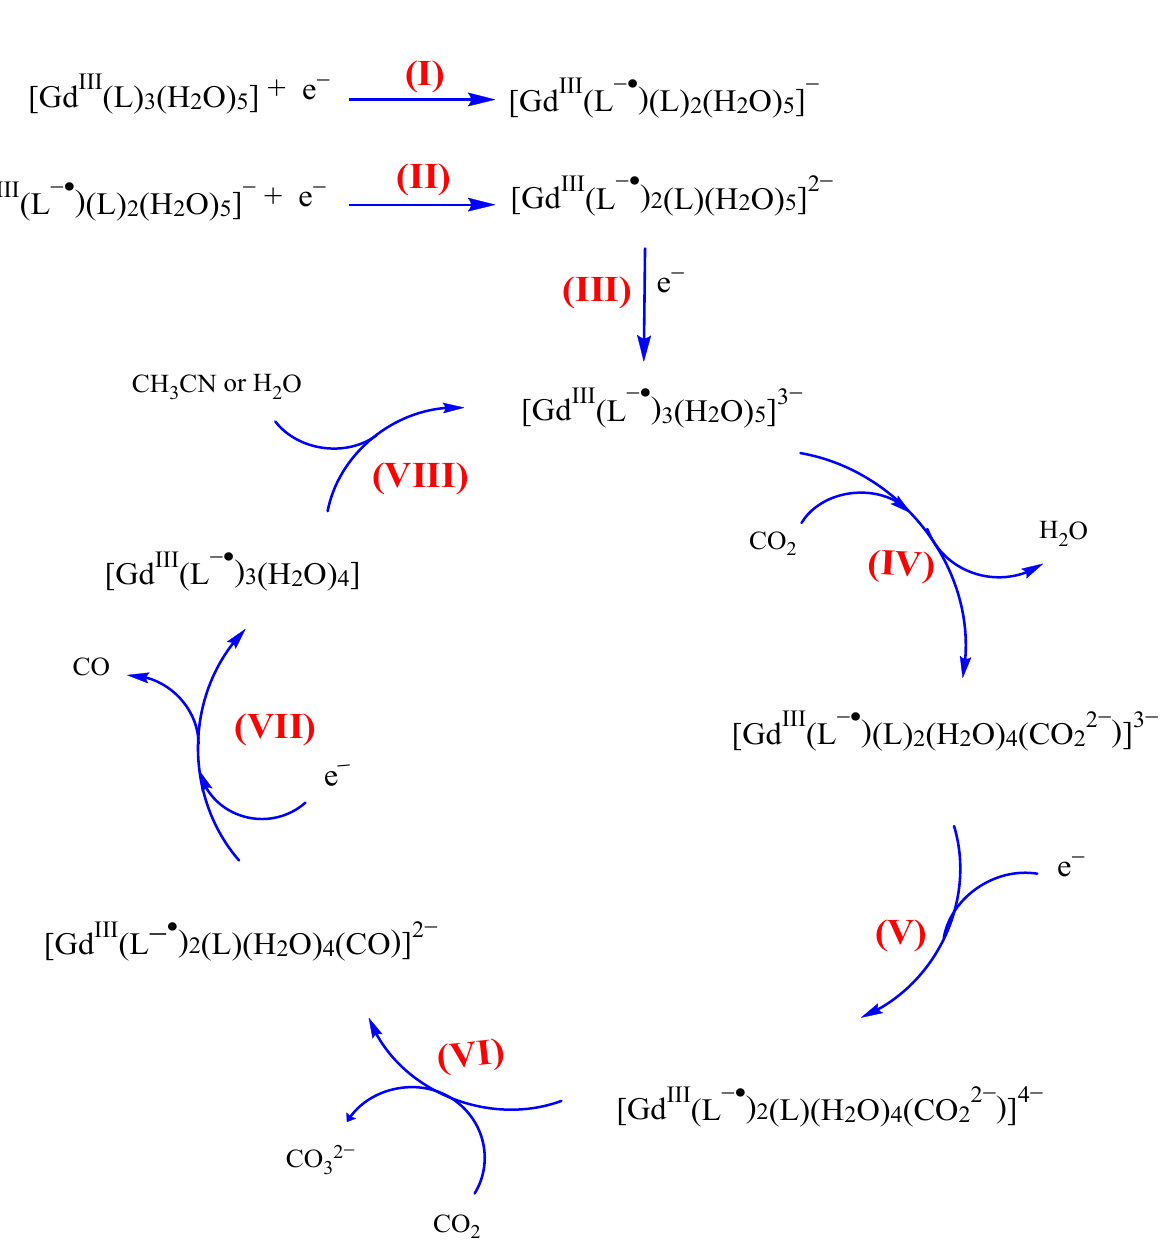
Scheme. 2. Proposed reaction mechanism for the electrocatalytic reduction of CO